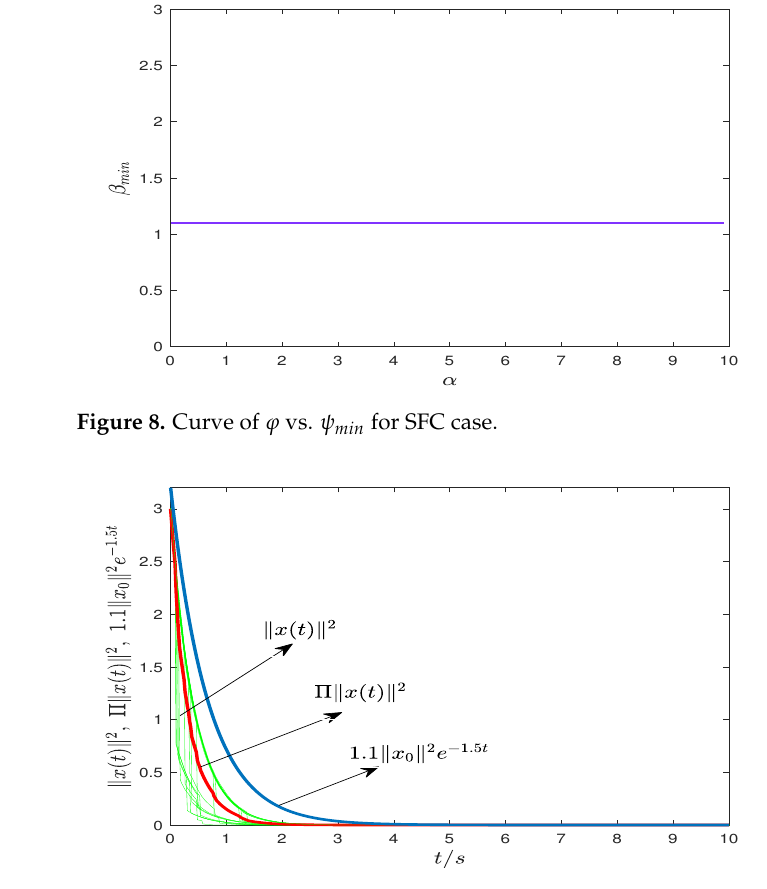
Figure 9. State response curve of closed-loop system for SFC case.